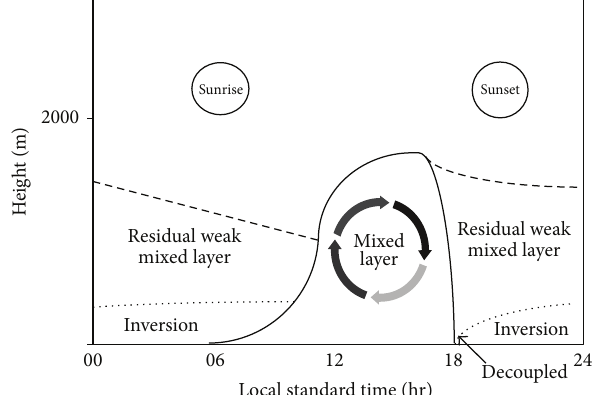
Figure3:Typicaldiurnalcycleofmixing-layerdepthredrawnbased on Oke [7].